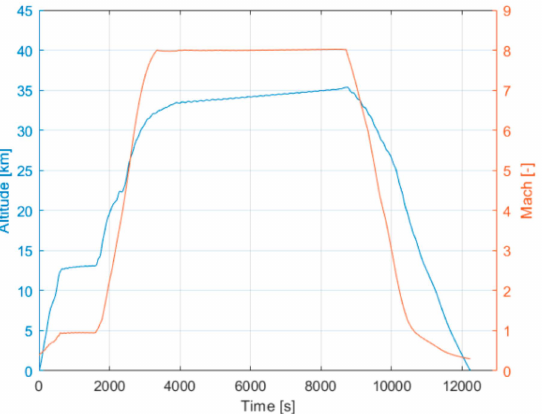
Figure 3. STRATOFLY MR3 mission profile in terms of altitude and Mach number as function of time [19].